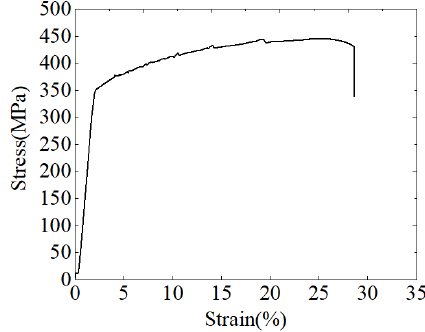
Figure 8. Real stress-strain curve.